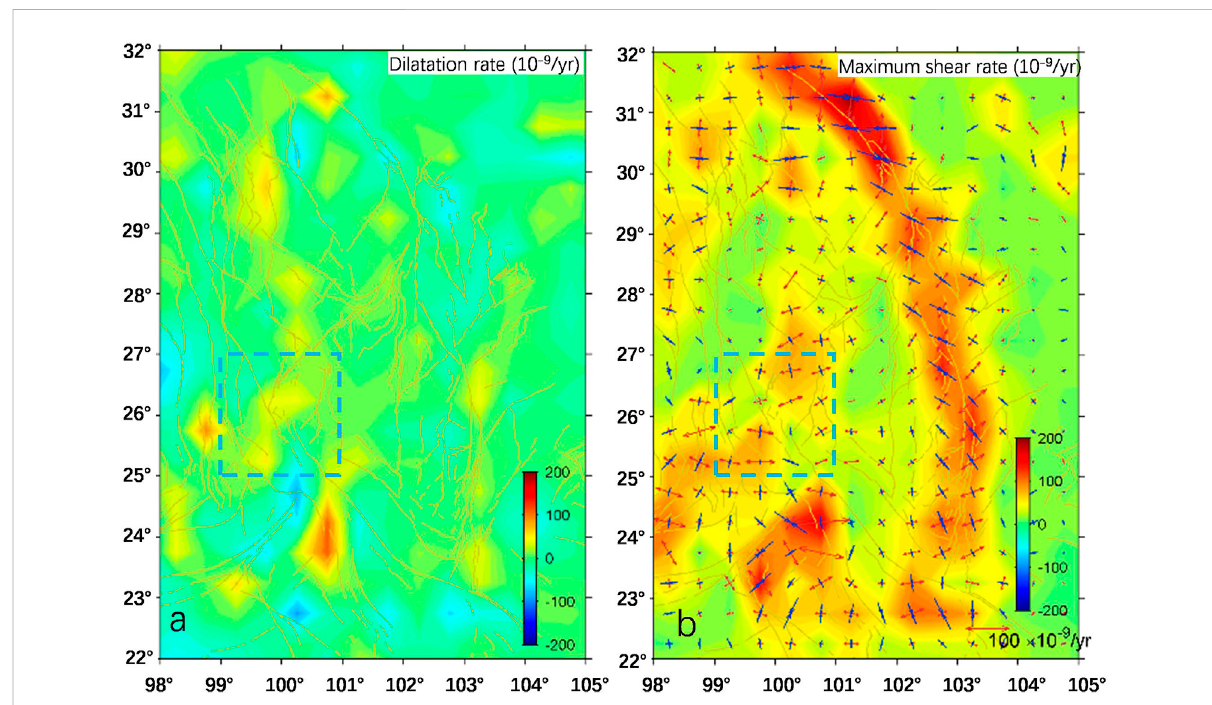
FIGURE 5 Continuumdeformation fi eldofChuan-DianareaderivedfrominterpolationofGPSvelocities.Bluedottedsquaredenotestheextensionalarea in Figure 4. (A) Dilatation rate, with extension positive. (B) Strain rates. Maximum shear strain rate is shown in background colour and principal strain rates are shown as vector